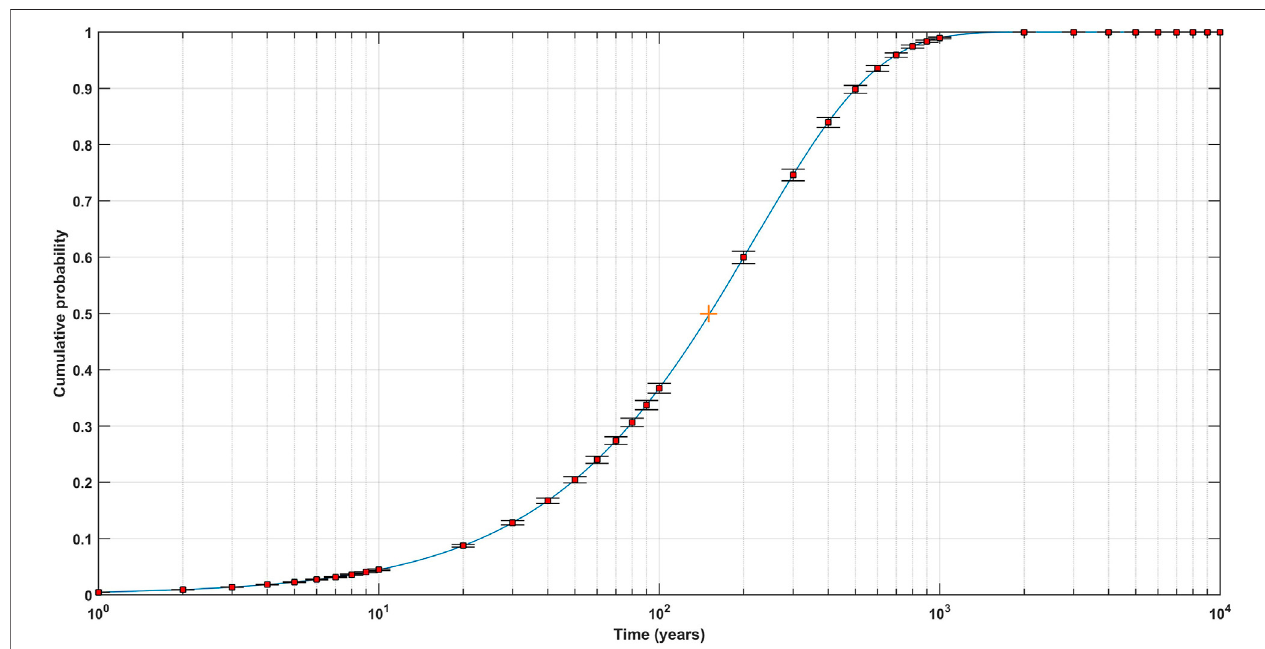
FIGURE5| Cumulativeprobabilityofoccurrenceversusforecastingtime intervalforaLáscar1993-like (i.e.,0.1 km 3 )eruptionoccurringanywherewithinthestudy area. The curve was calculated for a mean recurrence rate of 45.77 events per 10 kyr and modelled as a homogeneous Poisson point process. Ranges of probabilities (blackintervals)areillustratedatspeci fi ctimes(redsquares)fortheminimumandmaximumrecurrenceratescalculated,whichvarybetween44.36and47.12eventsper 10 kyr, respectively. Orange cross indicates the time when a cumulative probability of 50% is achieved. Another plot considering different recurrence rates is provided in Supplementary Figure S14